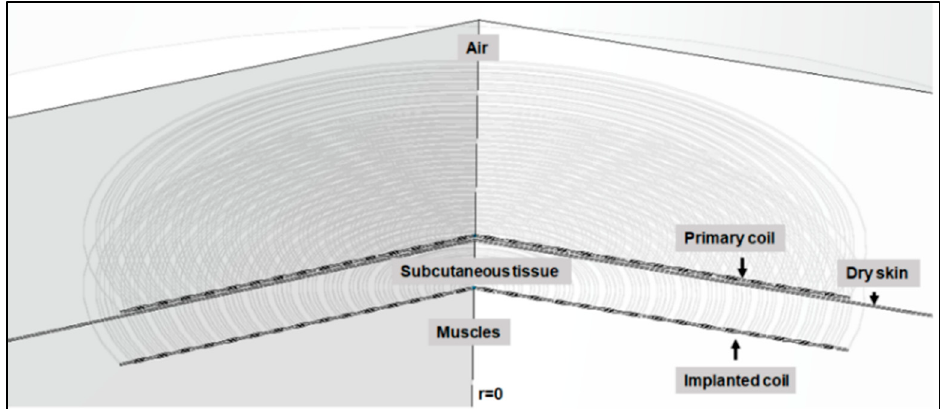
Figure 5. Constructed geometry in COMSOL for in silico model (Symmetry at r = 0).